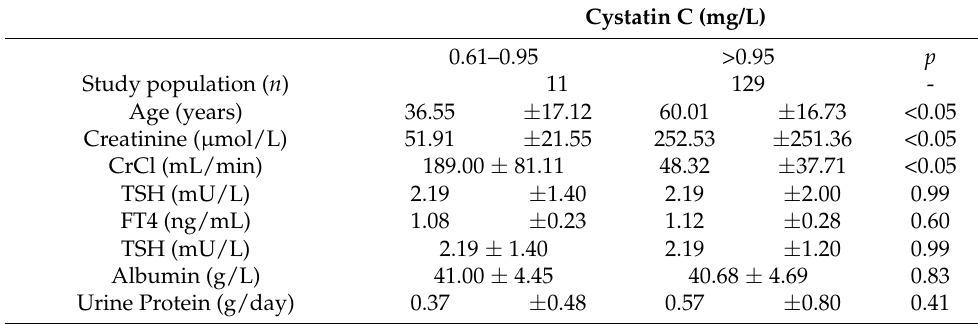
Table 2. Biochemical characteristics of patients at normal vs. abnormal cystatin C levels.